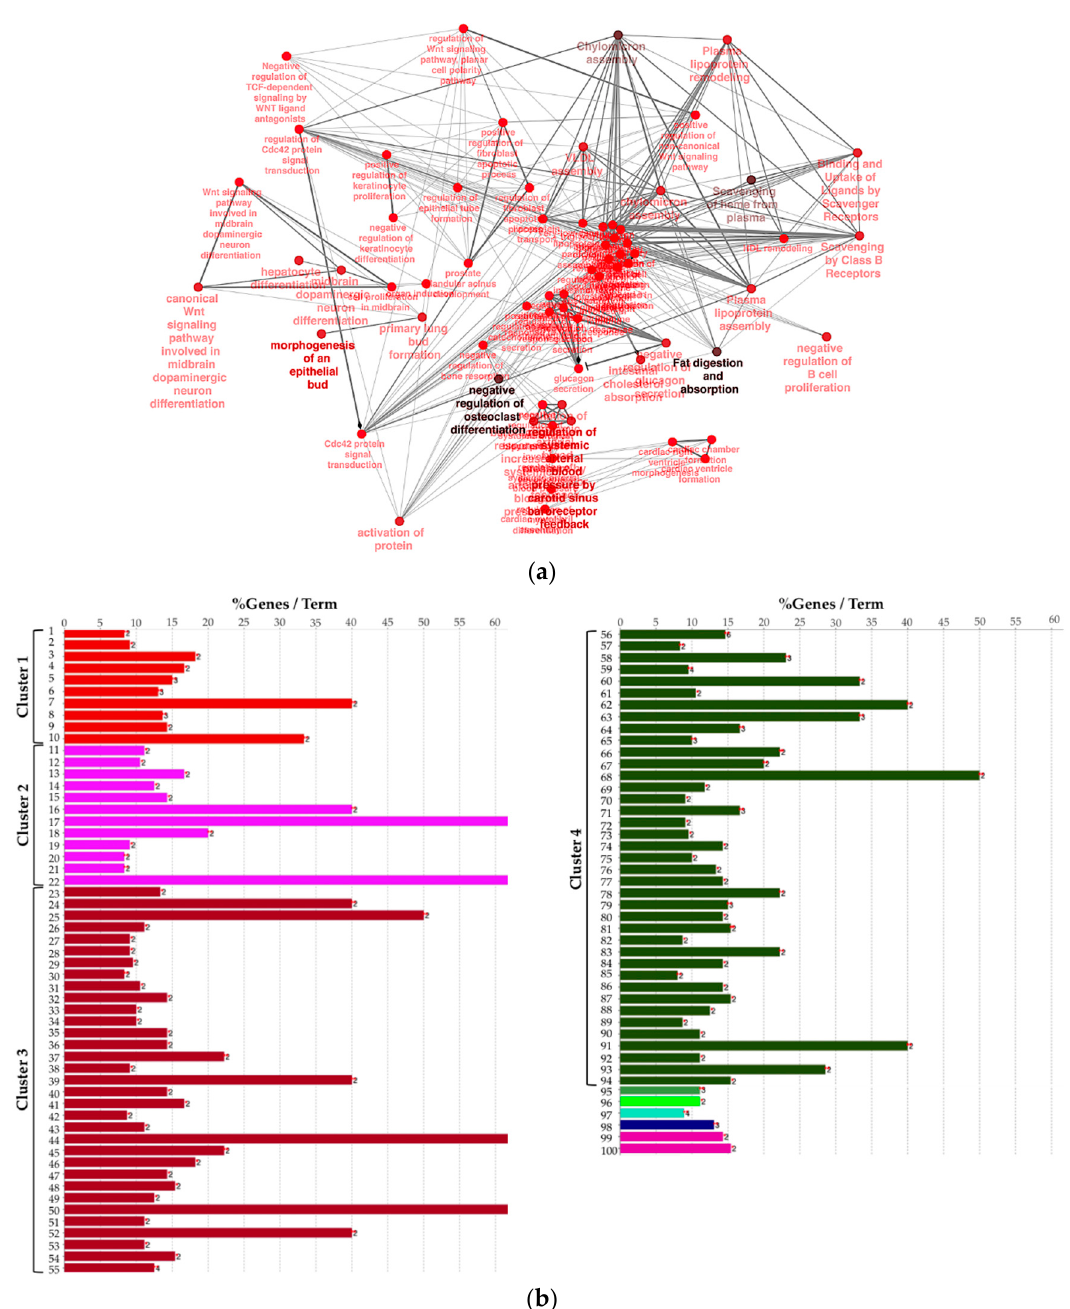
Figure 3. ( a ) Biological network including significant enriched terms related to KEGG, GO Biological Process, Reactome pathway, and GO immune system process databases. ( b ) Bar plot showing the grouping of the terms showed in the network, see text and Supplementary File 1 for details.